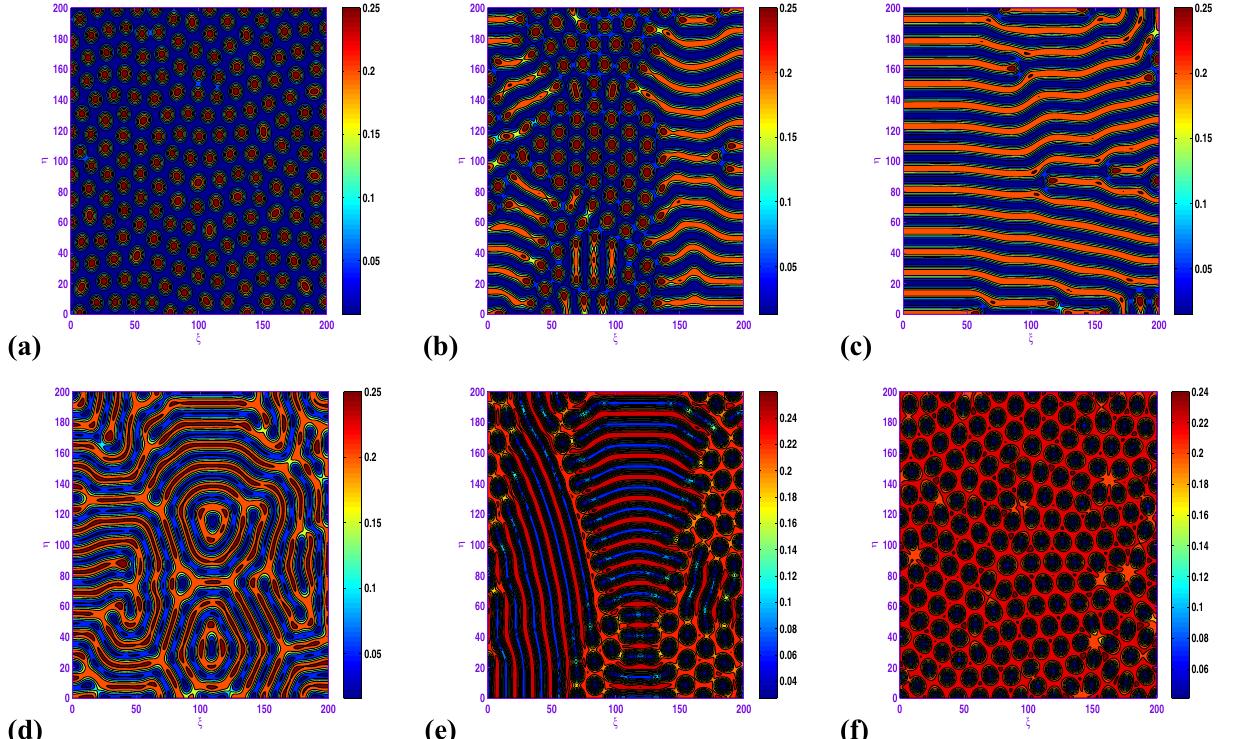
Figure 13. Transition of spatial dynamics of the prey population ( u ) in the model (15) at t = 5000 , for the set: a = 2.1 , b = 3.01 , β = 6.0 , d d = 0.2 ; ( b ) d = 0.24 ; ( c ) d = 0.261 ; ( d ) d = 0.3 ; ( e ) d 1 = 0.1 , 2 = 20.0 and ( a ) d = 0.32 ; ( f ) d = 0.34